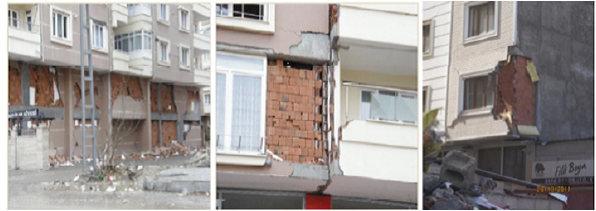
Figure 26. Damage in the outer walls of a reinforced concrete build- ing in Van city due to separations in the walls (Cagatay I.H.,